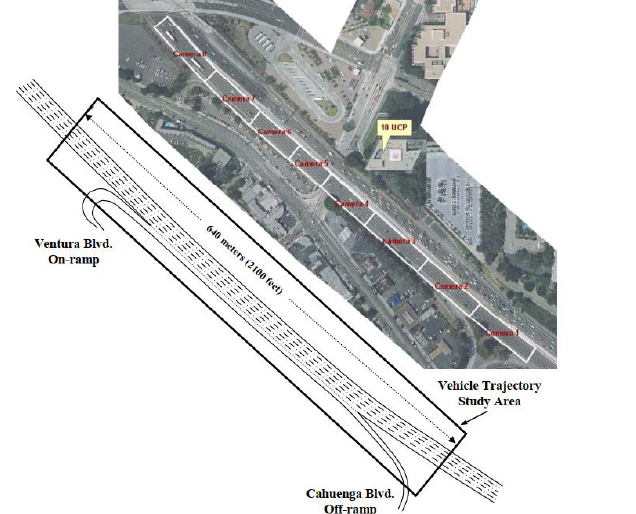
10 of 17 Figure 7. The learning rate changes with the number of iterations.